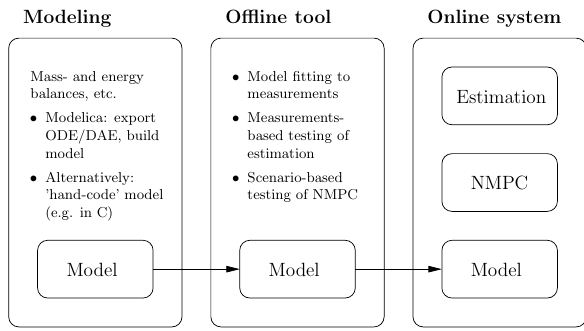
Figure 1: Overview over workflow in model usage. Data storage, data acquisition/exchange, and GUI not